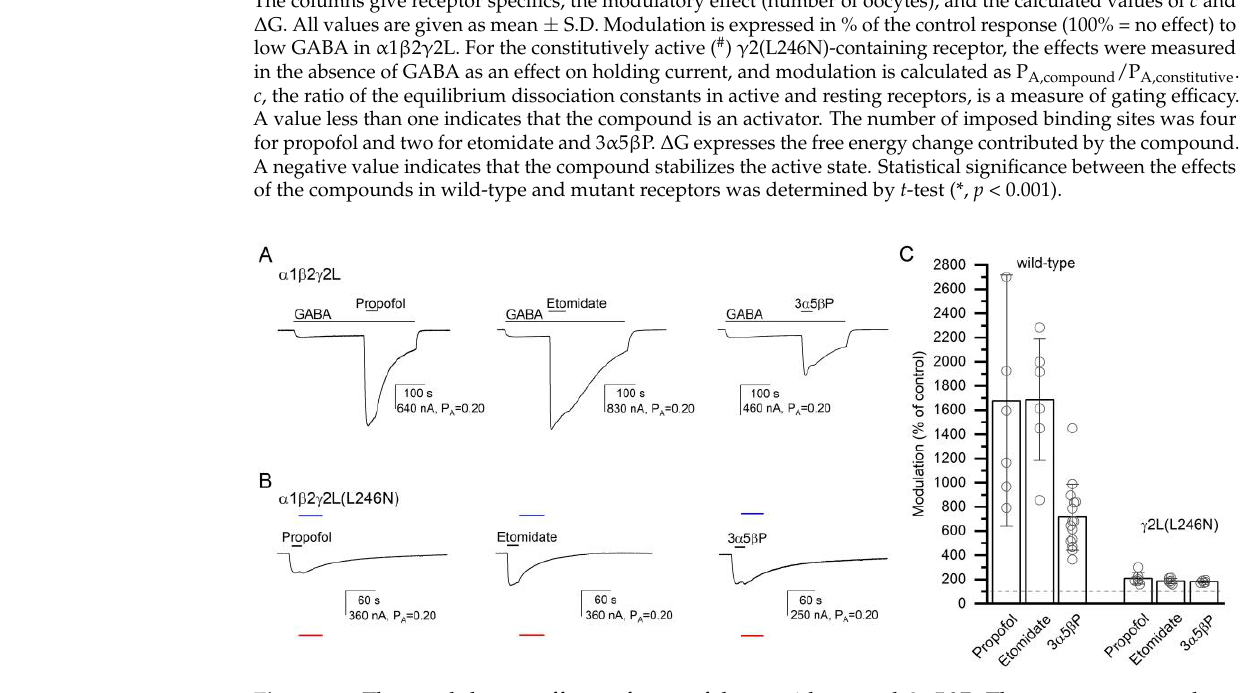
Figure 6. The modulatory effects of propofol, etomidate, and 3 α 5 β P. The current traces show the potentiating effects of 50 µ M propofol, 50 µ M etomidate, or 10 µ M 3 α 5 β P in the α 1 β 2 γ 2L receptor activated by 2–4 µ M GABA ( A ) or the direct-activating effects of the compounds in the α 1 β 2 γ 2L(L246N) receptor ( B ). The blue and red lines show the current levels in the same cell in the presence of 200 µ M picrotoxin (assumed P A = 0) or 1 mM GABA + 50 µ M propofol (assumed P A = 1), respectively. The modulatory effects are summarized in the column graph ( C ). The effects of the compounds are significantly reduced in the mutant receptor. In ( A ), modulation is calculated as the amplitude of the peak response to GABA + α 7-PAM divided by the amplitude of the response to GABA alone at the time of peak response to GABA + α 7-PAM. In ( B ), modulation is calculated as the ratio of the estimated P A in the presence and absence of α 7-PAM. Drug application durations are given with horizontal